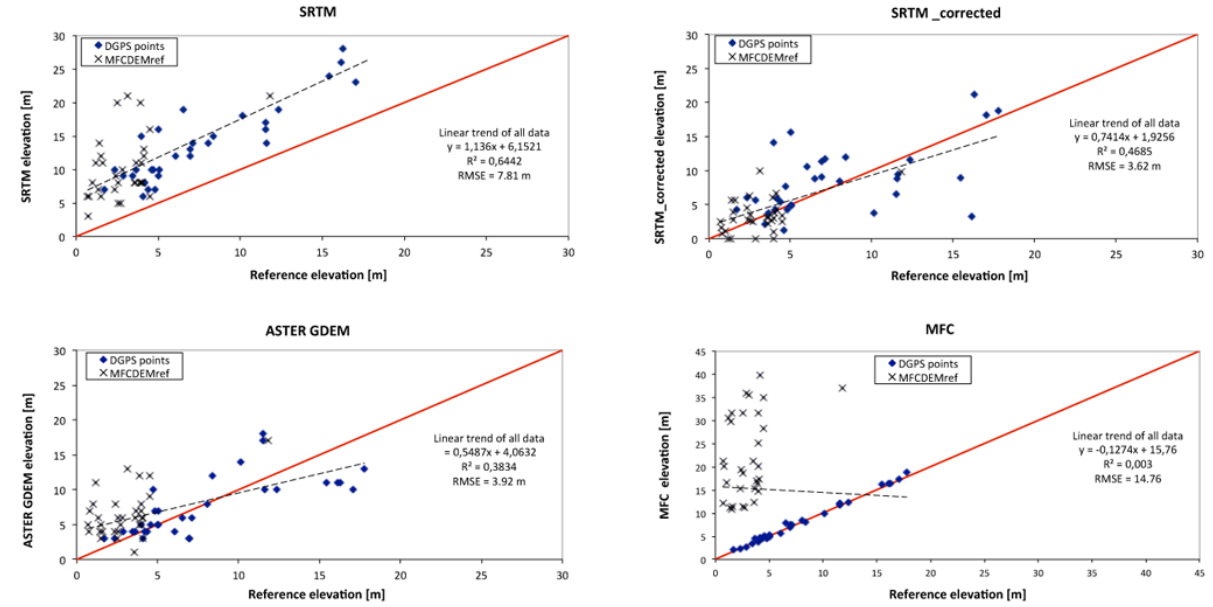
Fig. 7. Validation of SRTM, SRTM corrected, ASTER GDEM, and MFC against measured DGPS and MFC DEM ref points.